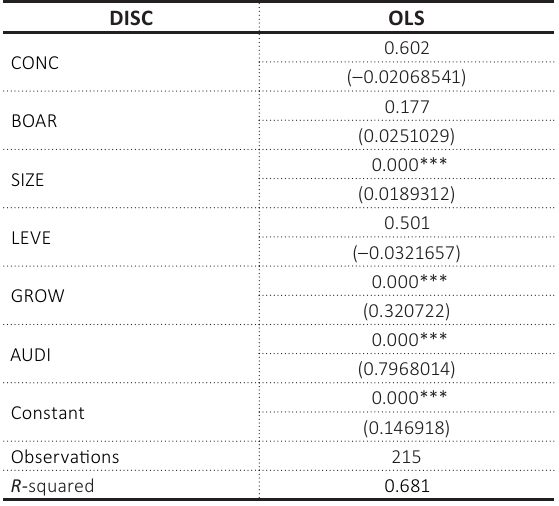
Table 4. Regression results